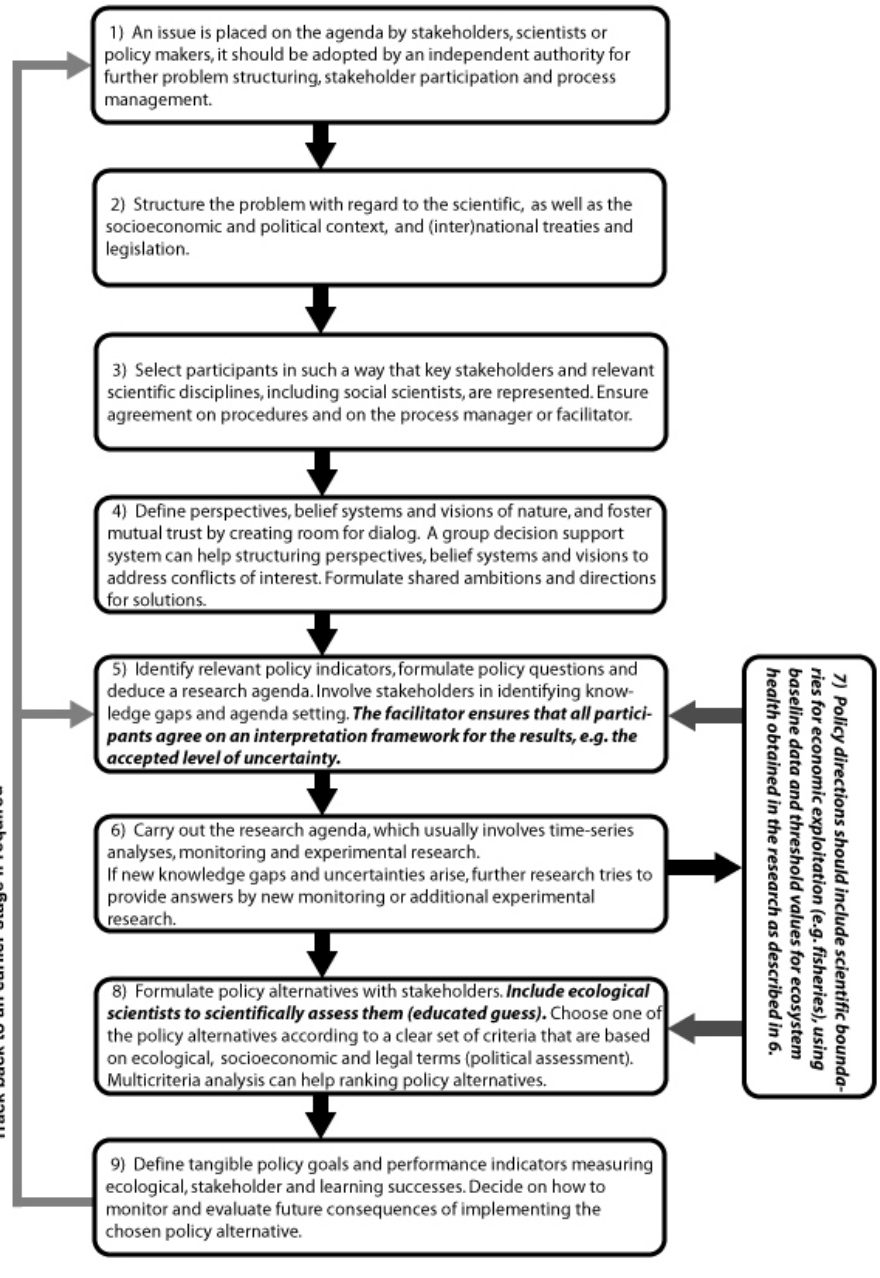
Fig. 3. Guidelines for evidence-based policy making in complex environmental issues based on Scialabba (1998), the Commission of the European Communities (1999), Costanza (2000), and the International Council for the Exploration of the Sea (2005). Additions, based on our analysis, are given in bold